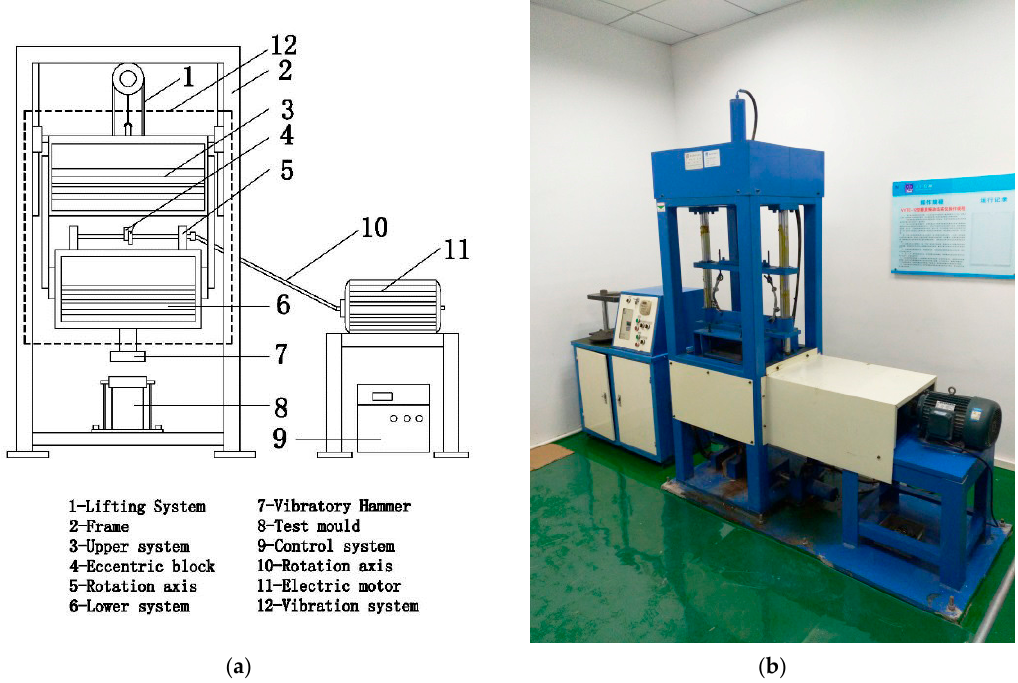
Figure 1. Vertical vibration test equipment (VVTE) schematic: ( a ) diagram of VVTE; and ( b ) photograph of VVTE.